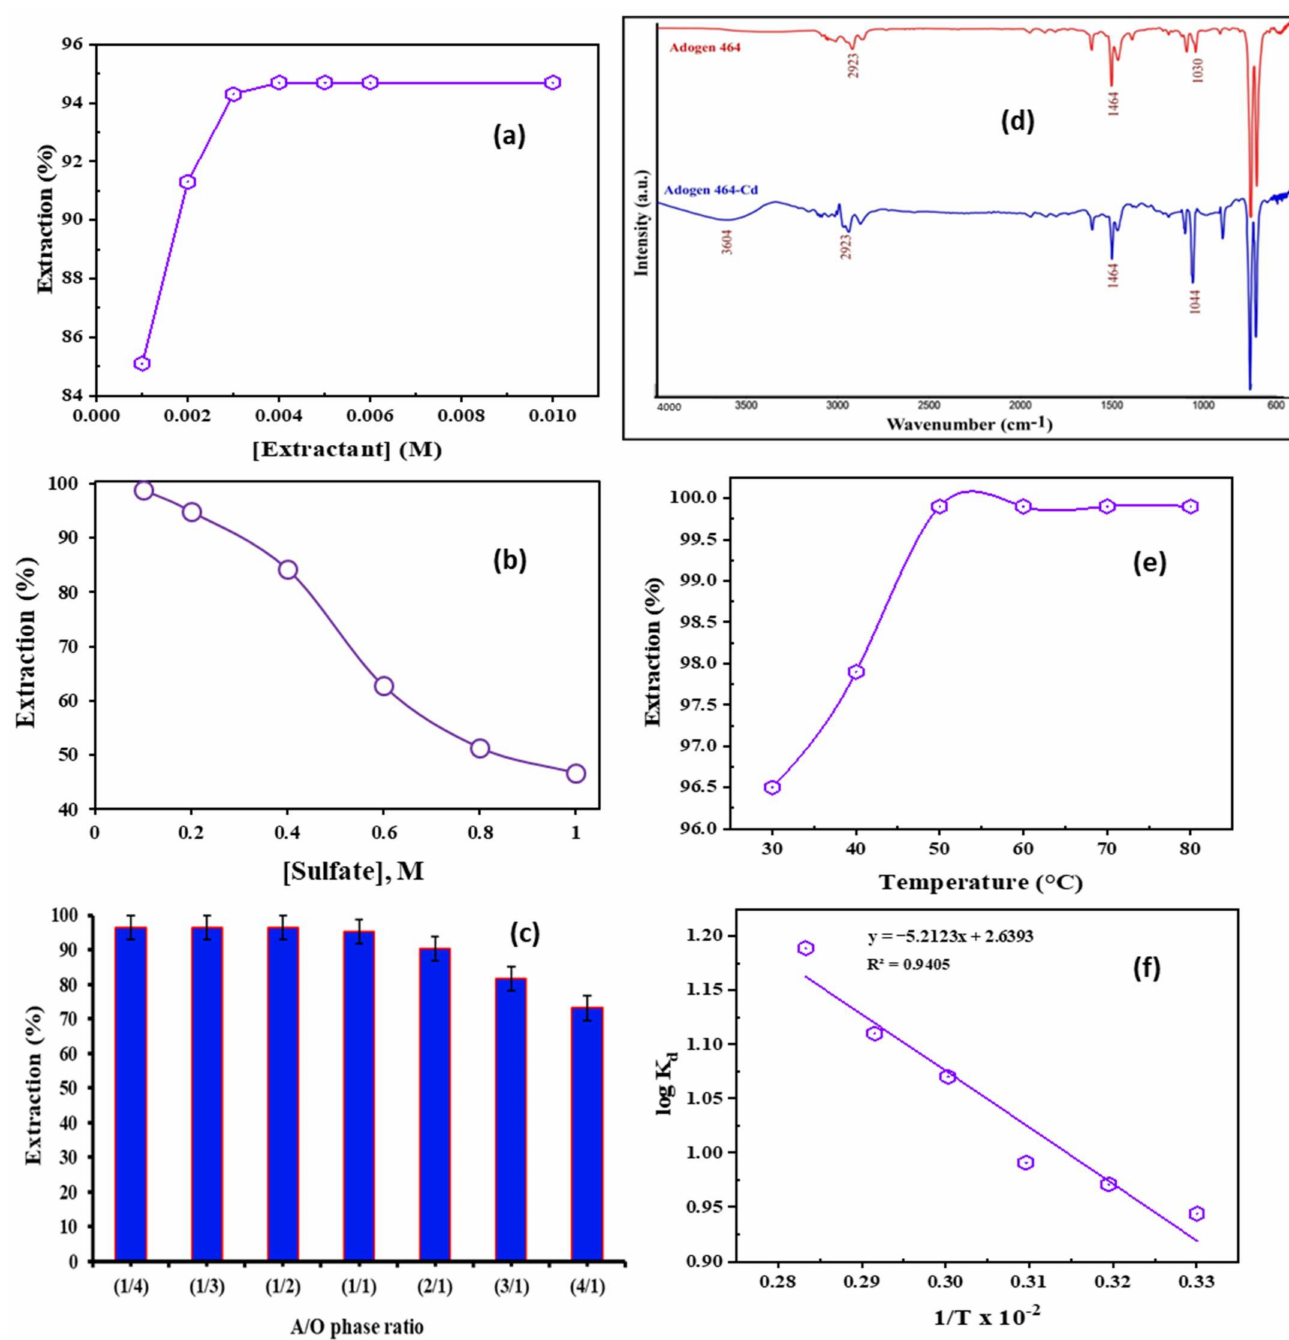
Figure 2. ( a ) Impact of Adogen 464 concentration upon Cd 2+ extraction (0.1 M Na 2 SO 4 , pH 5.0, O:A 1:1, 25 ◦ C, 10 min); ( b ) Impact of sulfate concentration upon Cd 2+ extraction (0.2 M Adogen 464, pH 5.0, O:A 1:1, 10 min, 25 ◦ C); ( c ) Impact of aqueous to organic ratio upon Cd 2+ extraction (0.2 M Adogen 464, pH 5.0, 0.1 M Na 2 SO 4 , 10 min, 25 ◦ C); ( d ) FTIR spectra of 0.2 M Adogen 464/toluene and cadmium/Adogen 464/toluene); ( e ) Impact of temp. upon Cd 2+ extraction (0.2 M Adogen 464, pH 5.0, 0.1 M Na 2 SO 4 , O:A 1:1, 10 min); ( f ) Influence of temp. on Cd 2+ partition coefficient (0.2 M Adogen 464, pH 5.0, 0.1 M Na 2 SO 4 , O:A 1:1, 10 min). Nayl (2010) described the relationship between quaternary ammonium extractants, which were employed to extract metal ions, as only occurring with a solvation reaction mechanism. The extraction of the Cd 2+ mechanism from SO 42 − media by R 3